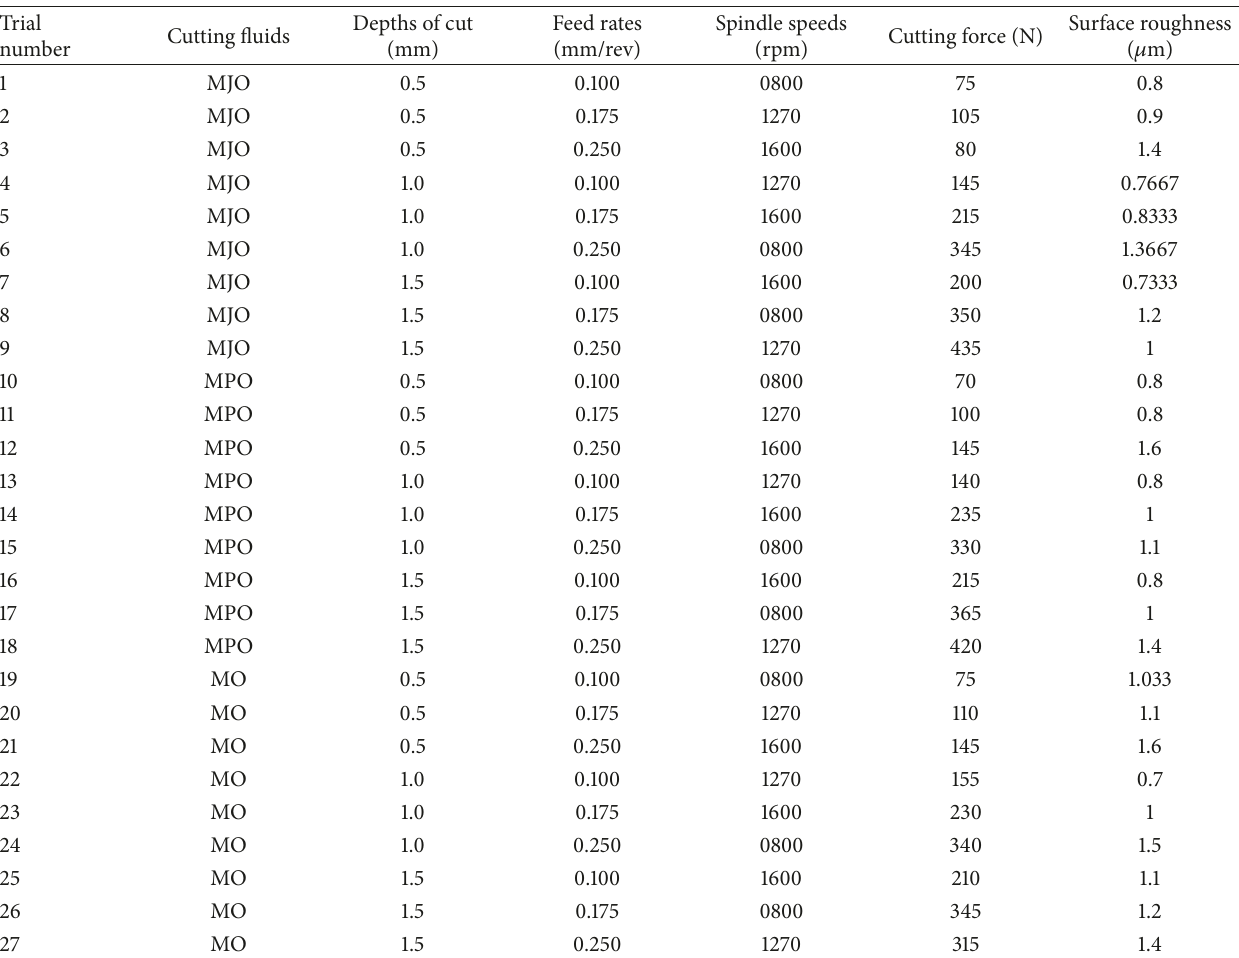
Table 4: Cutting force and surface roughness for interfamily